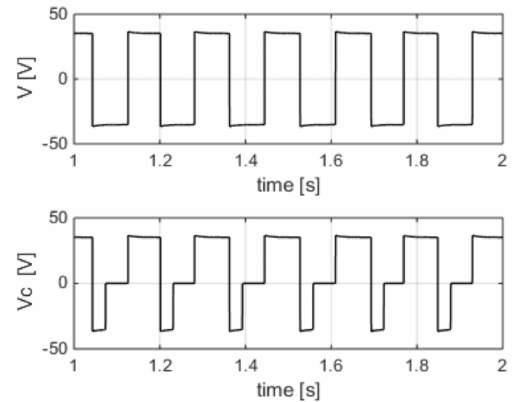
Figure 11. The waveforms of voltage that supply the motor winding (V) and the voltage across the upper coil (Vc).